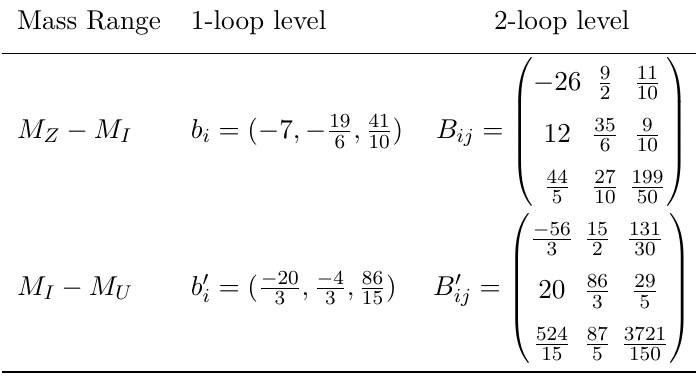
Table 2 . Beta coefficients at one-loop and two-loop